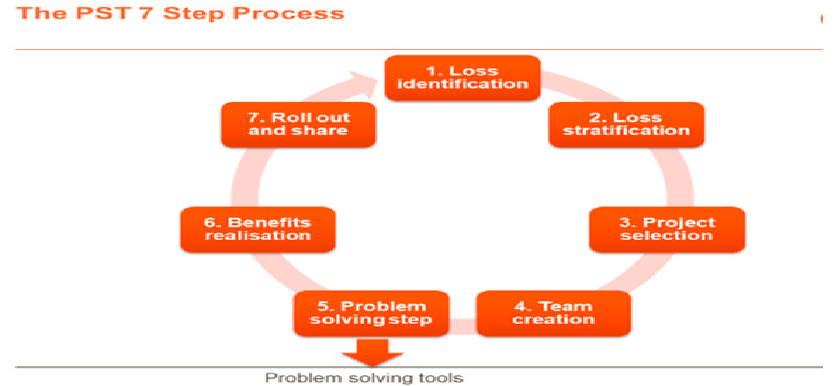
Figure 1. A seven-step in-company problem solving framework: based on and integrated with the Six Sigma D,M,A,I, C methodology and utilizing Lean and Six Sigma tools.